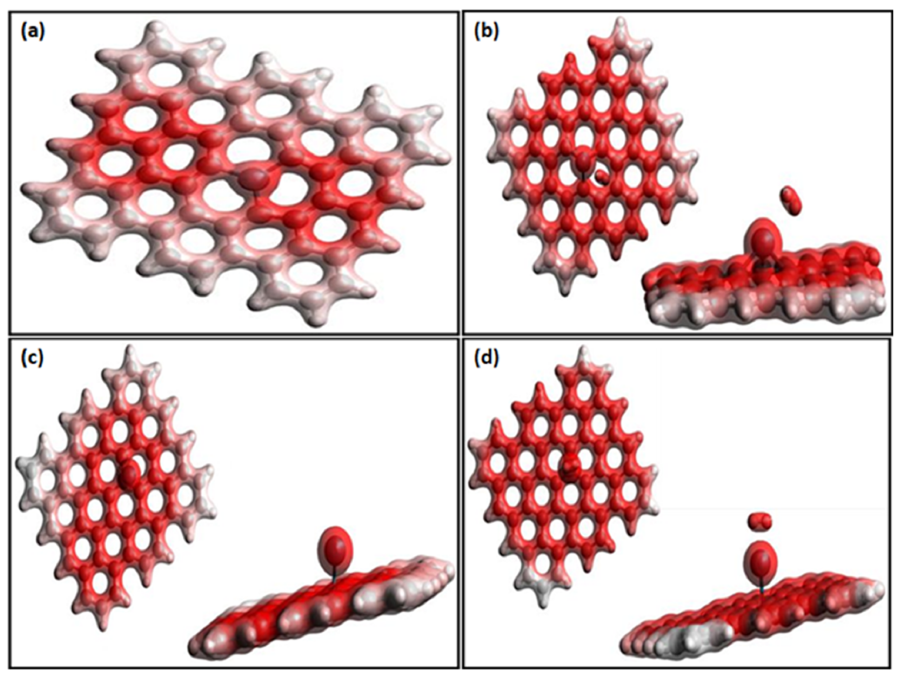
Figure 2. Electrostatic potential of ( a ) Pd-doped graphene, ( b ) Pd-doped graphene-H 2 , ( c ) Pd-decorated graphene, ( d ) Pd- decorated graphene-H 2 . The charge accumulation regions are in